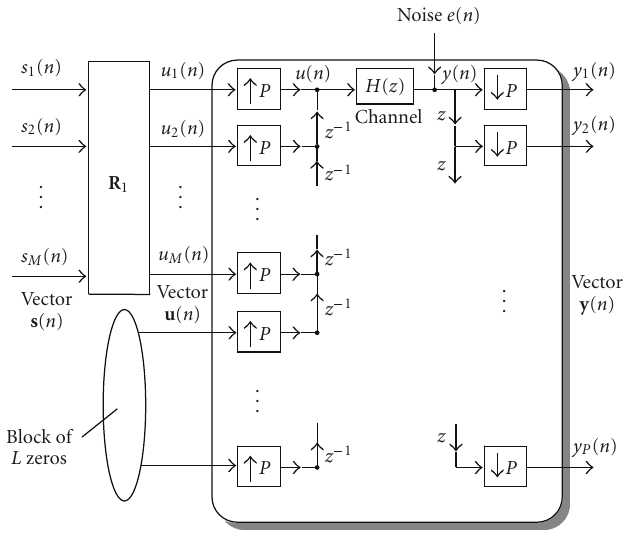
Figure 2: The zero-padding system with precoder R 1